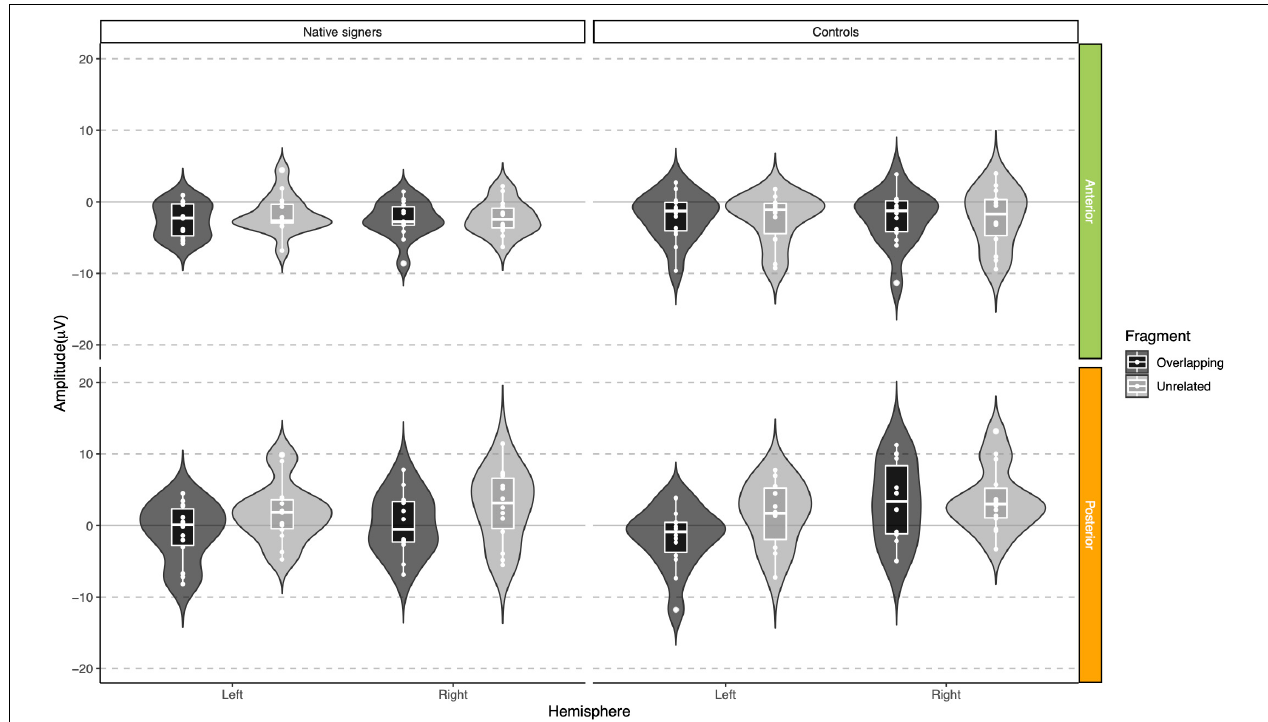
FIGURE 7 | Violin-boxplots depicting mean amplitude for the P350/positivity in the 200–400 ms time window for Native signers (left) and Controls (right) for the Unrelated (light gray) and Overlapping (dark gray) fragments across regions of